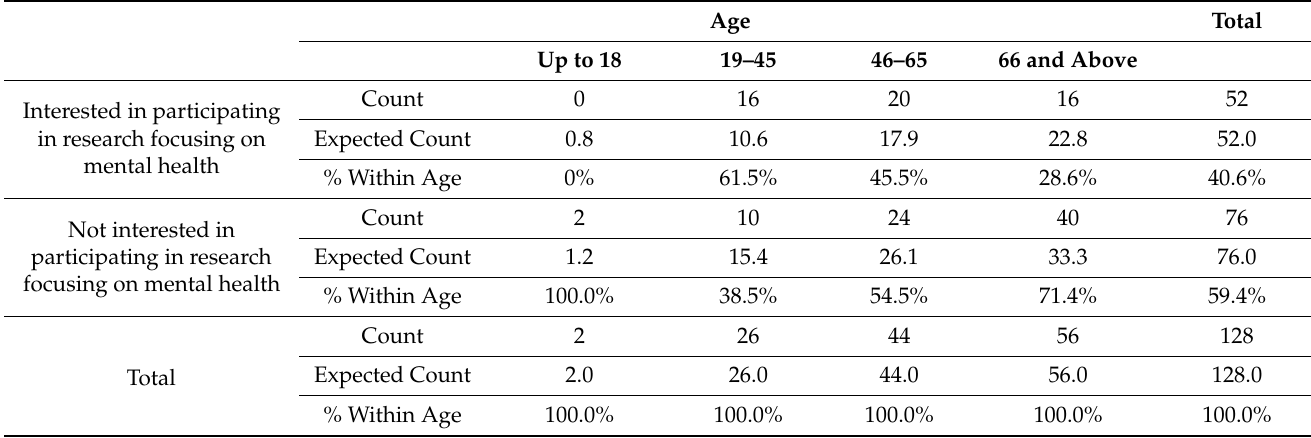
Table 8. Interest in Research Study Focusing on Mental Health by